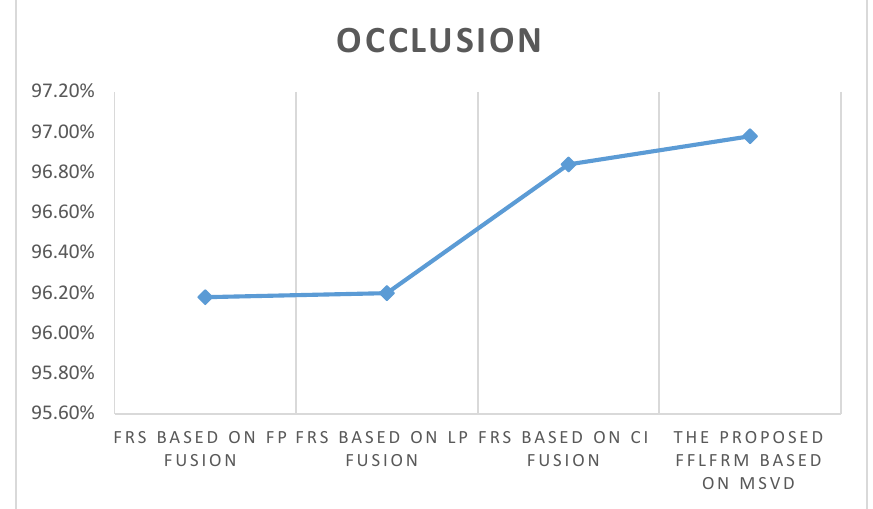
Fig. 8. Recognition accuracies of the four studied models in presence of occlusion in the face